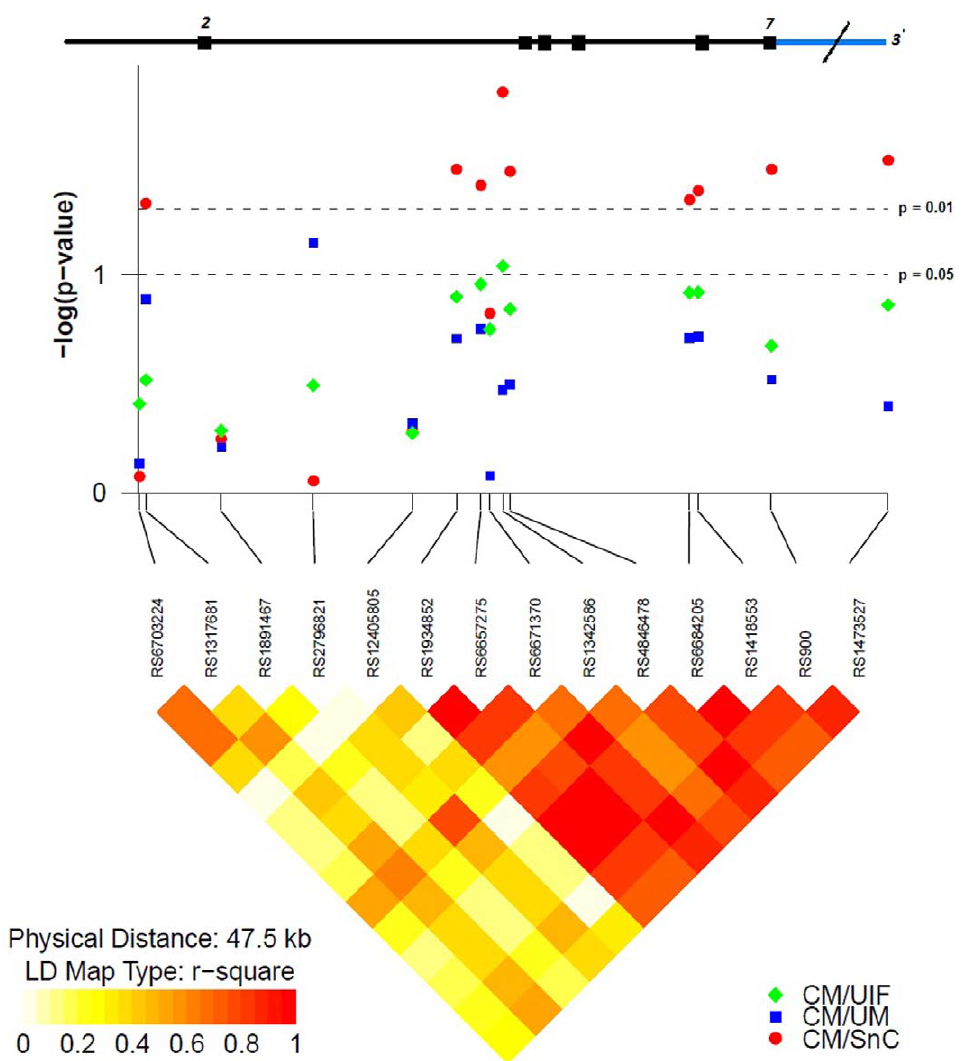
Figure 1. Association tests and LD analysis in the TGFB2 gene single-nucleotide polymorphisms (SNPs). The diagram represents in the vertical axis, the log10 of the P value of association tests of SNPs listed in the y-axis, obtained from logistic regression analysis. The points in red, blue and green represent the results of the association with the SNPs between cases of cerebral malaria (CM) and controls with severe no cerebral malaria (SnC), uncomplicated malaria (UM) and uninfected (UIF), respectively. The upper diagram shows a scale representation of the structure of the TGFB2 gene: exons are represented by boxes and marked with its number. The bottom of the diagram represents the LD between a pair of SNPs measured by r 2 . The image, below and to the left, corresponds to the color scale representing the values of LD, from yellow (r 2 =0) to red (r 2 =1). This diagram is an adaptation of the figure produced by the snp. plotter R package.